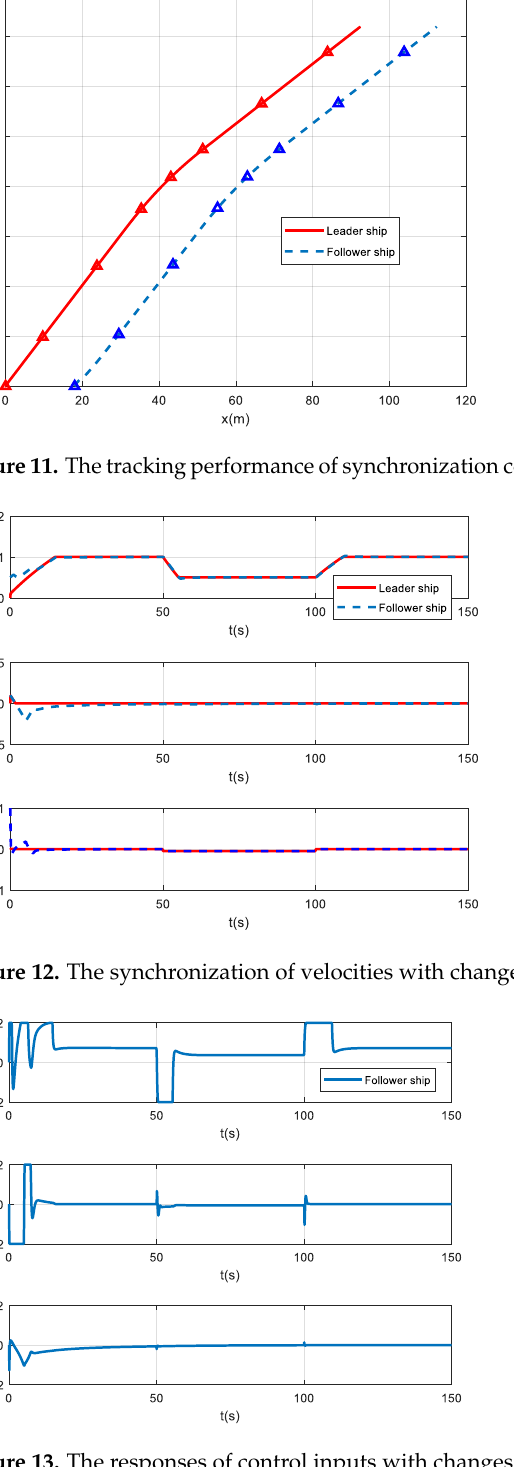
Figure 13. The responses of control inputs with changes in velocities and course.